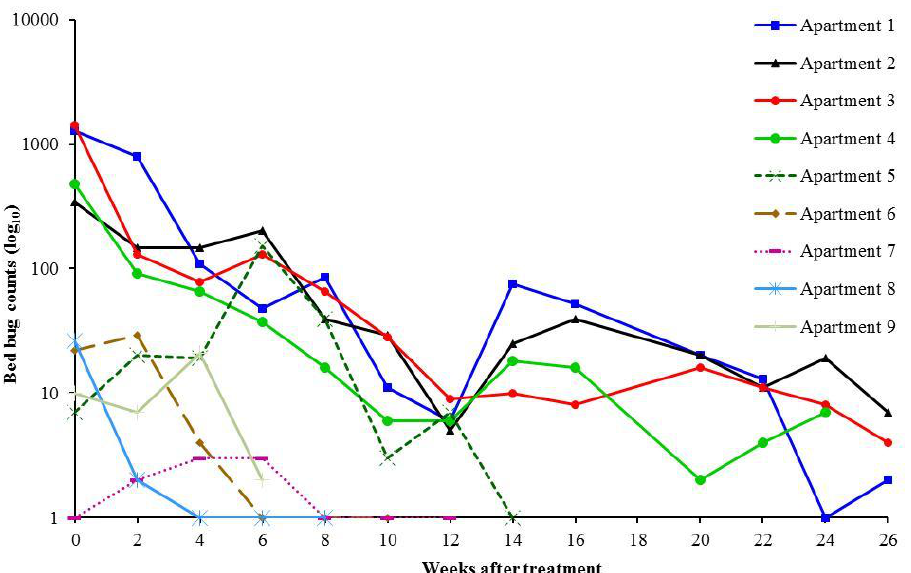
Figure 3. Bed bug count reduction (Climbup interceptors + visual inspection) in nine apartments after implementation of the bed bug management